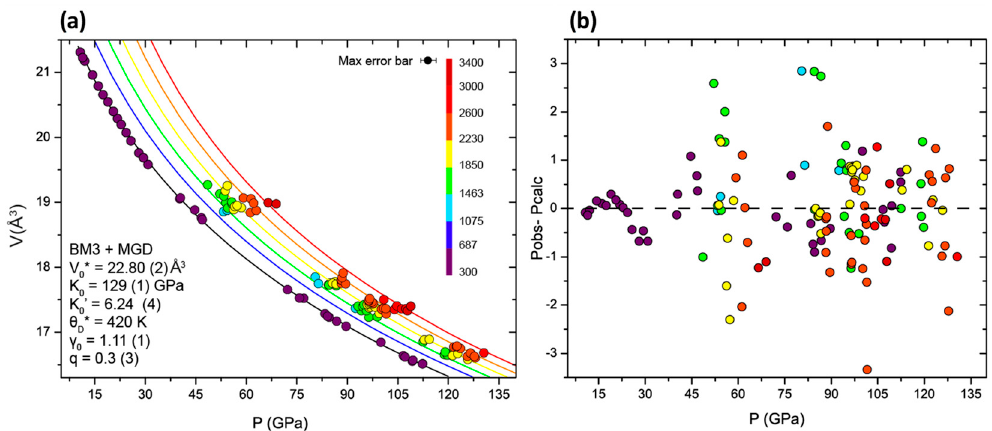
Figure 4. Results obtained fitting our data with the Mie Grüneisen Debye thermal model. ( a ) Experimental points with the isotherms calculated between 300 and 3500 K; ( b ) pressure residuals for the fit in GPa, colors correspond to the inset in (a).